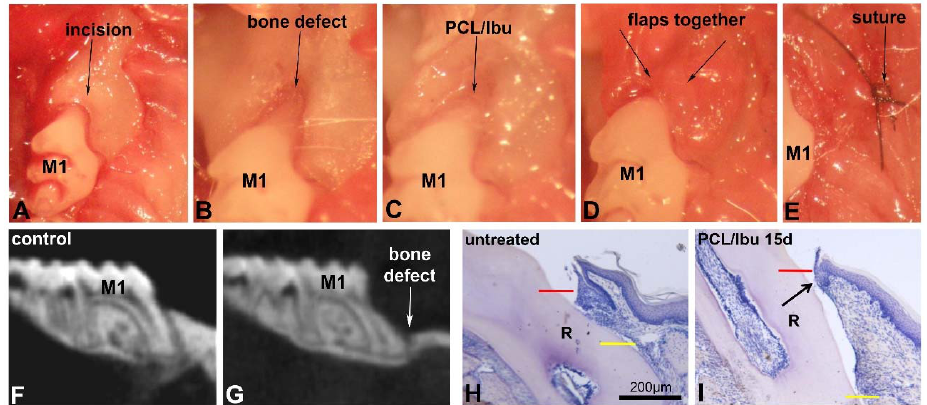
Figure 3. Surgical bone defect model and treatment with PCL/Ibu membrane ( A – I ). ( A – E ) demonstrate the surgical procedure for creating the mesial bone defect. After anesthesia, sulcular incision ( A ) was given along maxillary first molar and extended anteriorly on the mesial aspect of the first molar for efficient raising of palatal and vestibular flaps so that they do not hinder the bone drilling procedure. The exposed bone was drilled to create the intrabony defect ( B ). The bone over and around the mesial root of the first molar was removed. Constant irrigation with physiological saline was maintained to avoid overheating of the bur and the bone area concerned. The drilled bone was, later, nicely irrigated, cleaned, and dried to remove all the bone chips and debris. PCL/Ibu functionalized membrane was placed on the created bone lesion ( C ) in such a manner that its ends could be blocked beneath the vestibular and palatal flaps. Palatal and vestibular flaps were approximated covering the PCL/Ibu membrane underneath and sutured (9 ‐ 0 ETHILON* Polyamide 6/6) or glued to retain the membrane underneath ( D , E ). ( F ) micro ‐ CT view before the bony defect and ( G ) after bony defect. ( H , I ) Histology of periodontal wound healing at 15 days. Red line = cementoenamel junction, yellow line = bone level. ( I ) Arrow showing short epithelial attachment in test. M1: first upper molar, R: root.